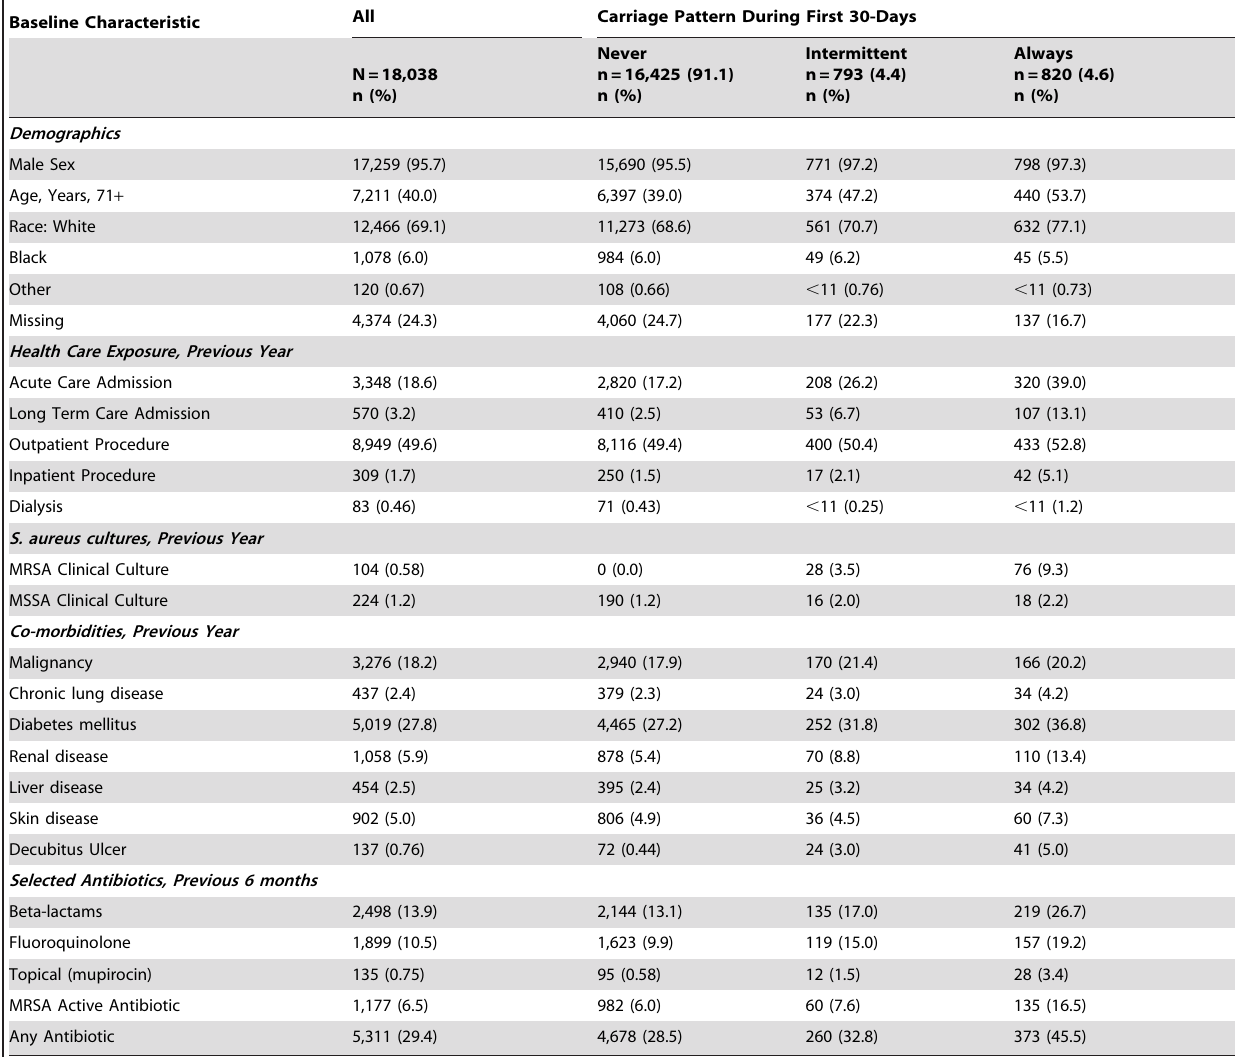
Table 1. Baseline Characteristics for Study Cohort by 30-Day Carriage Pattern.